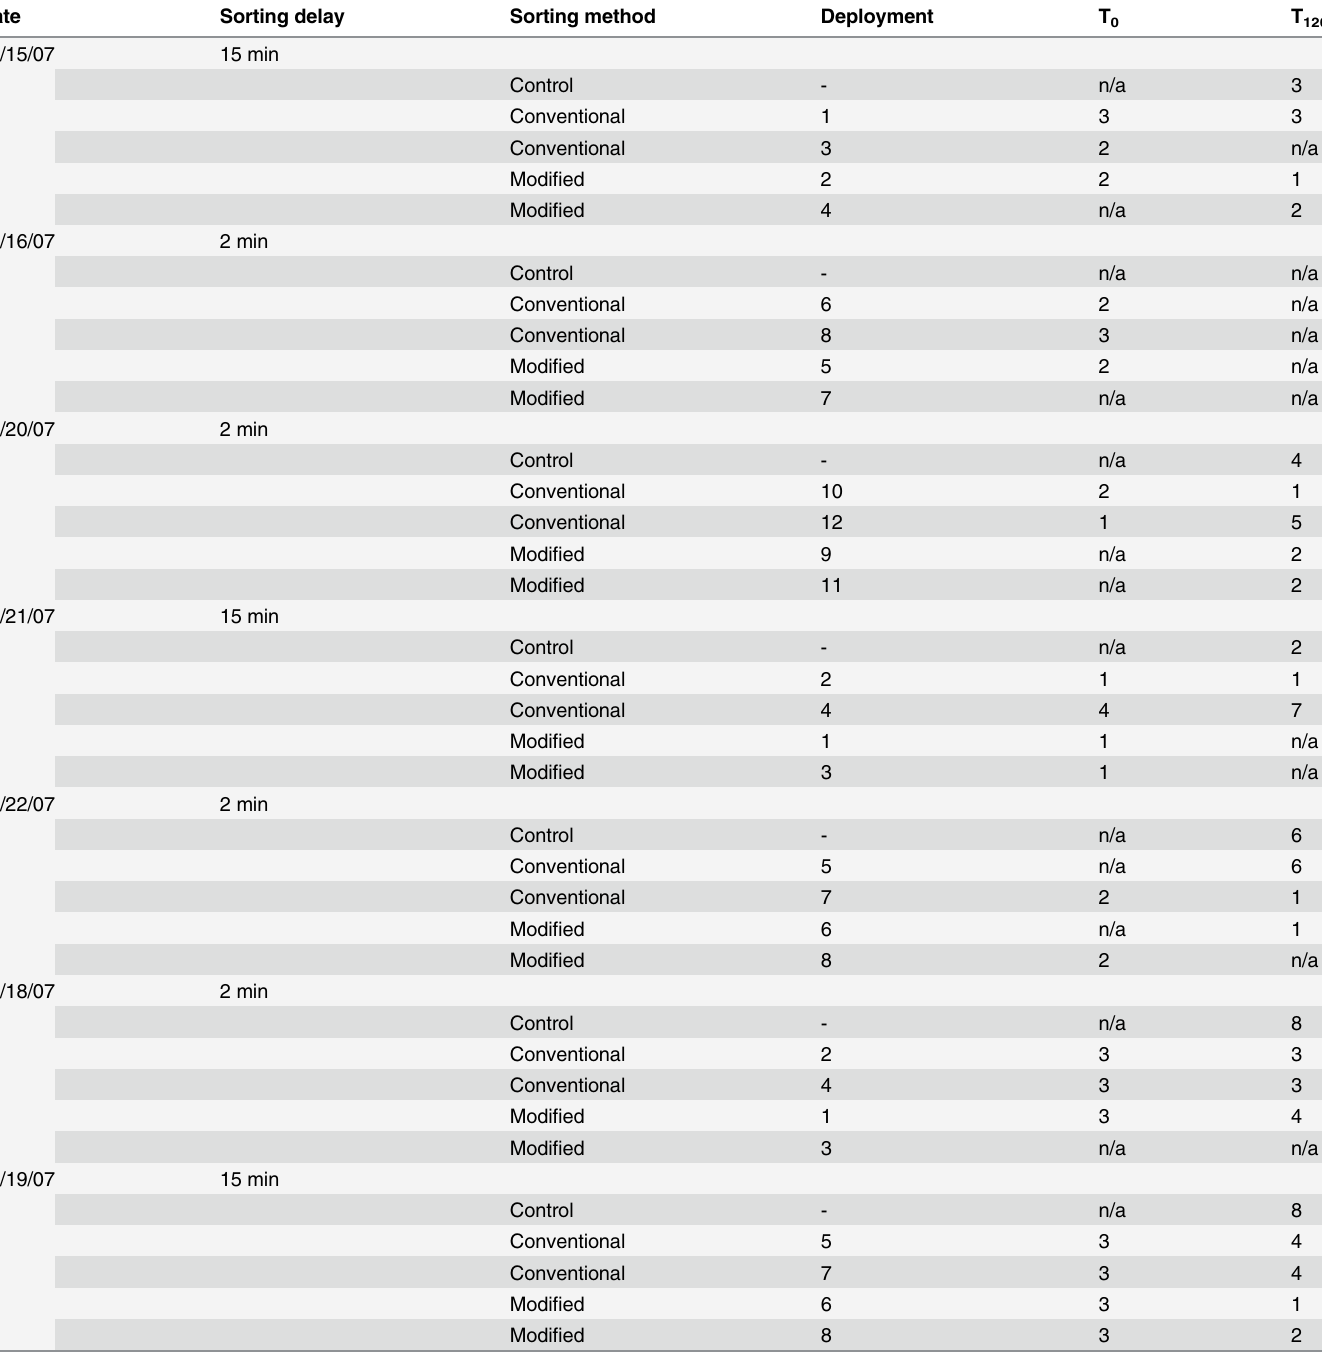
Table 1. Number of yellowfin bream per deployment from which blood plasma samples were obtained at T 0 and T 120 in each treatment group (2- or 15-min delay in starting either conventional or modified sorting).